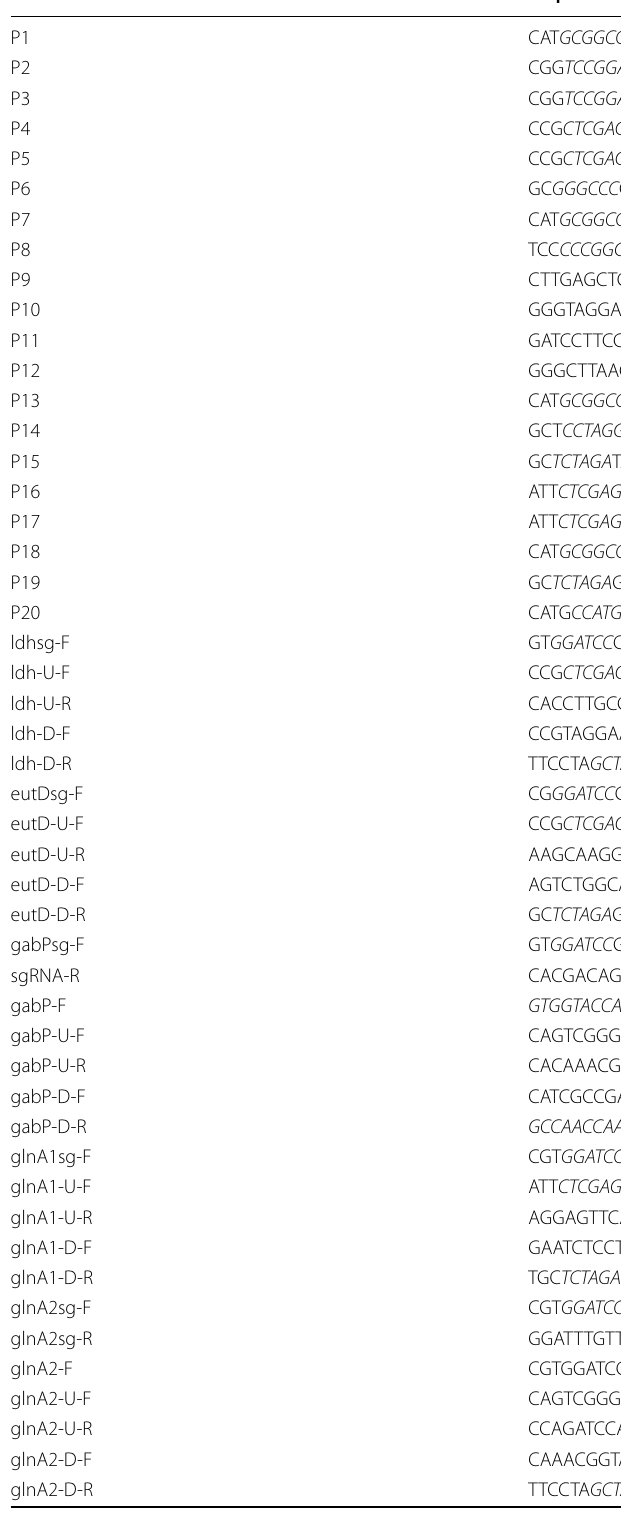
Table 2 The main primers used in this study Primers